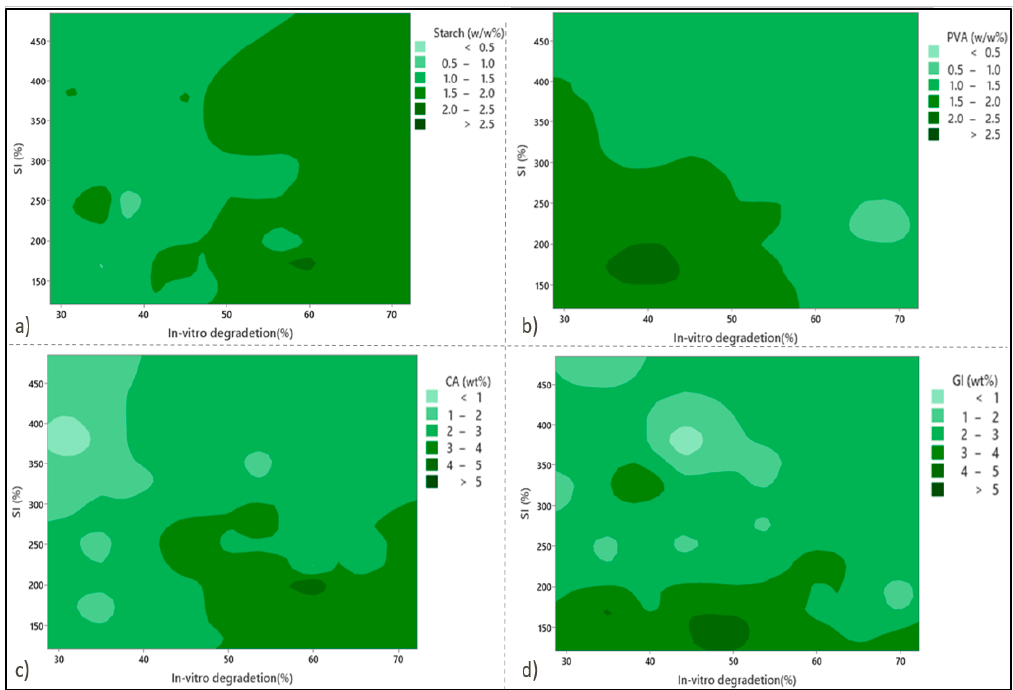
Figure 1. Contour plots show the effects of the independent variables on the swelling index (SI%) and weight loss (WL%) in ( a ) starch, ( b ) PVA, ( c ) citric acid, and ( d )